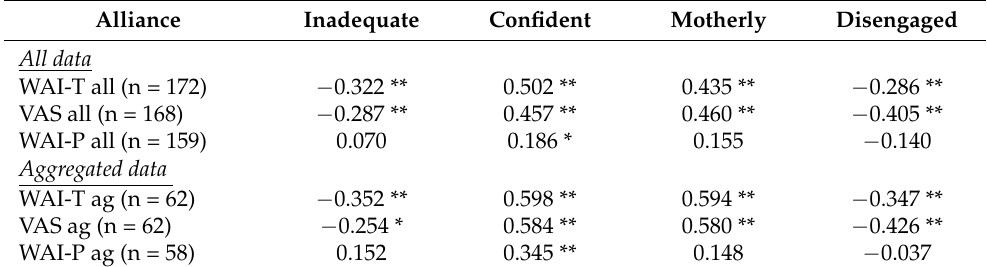
Table 5. Pearson correlation between the CT subscales and alliance measures. Alliance Inadequate Confident Motherly